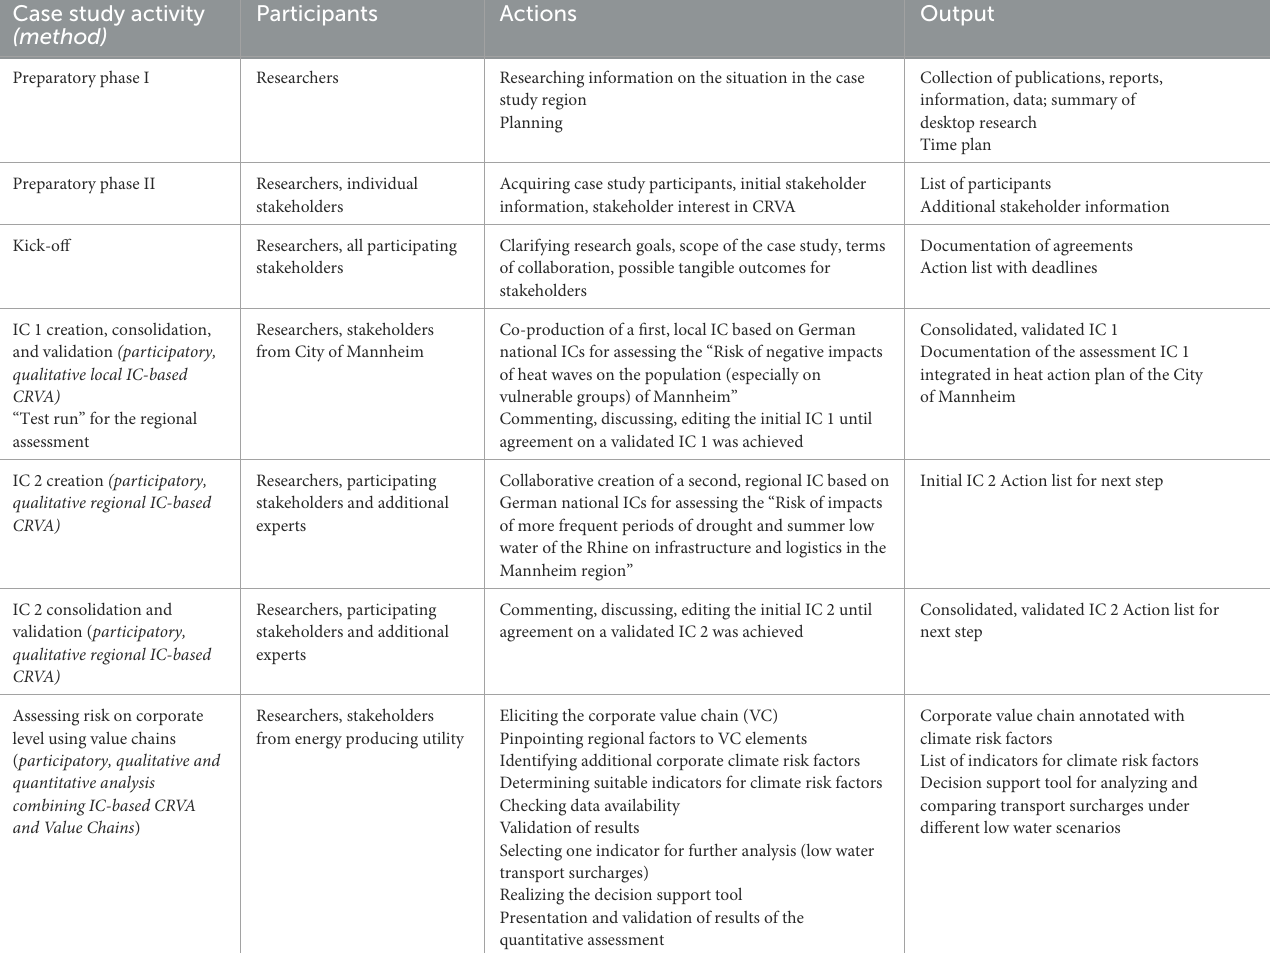
TABLE 1 Overview of the case study activities (optional: methods ), participants, actions, and